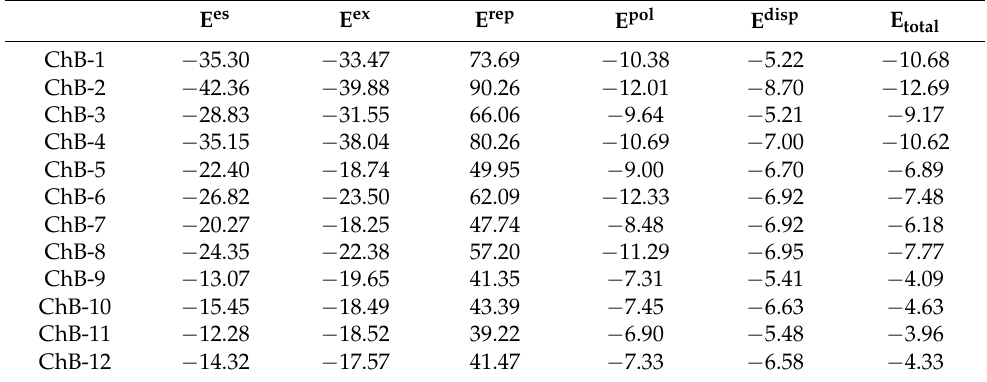
by adding a spodium bond (SpB) and its enhancing mechanism. Figure 5 shows the dia-